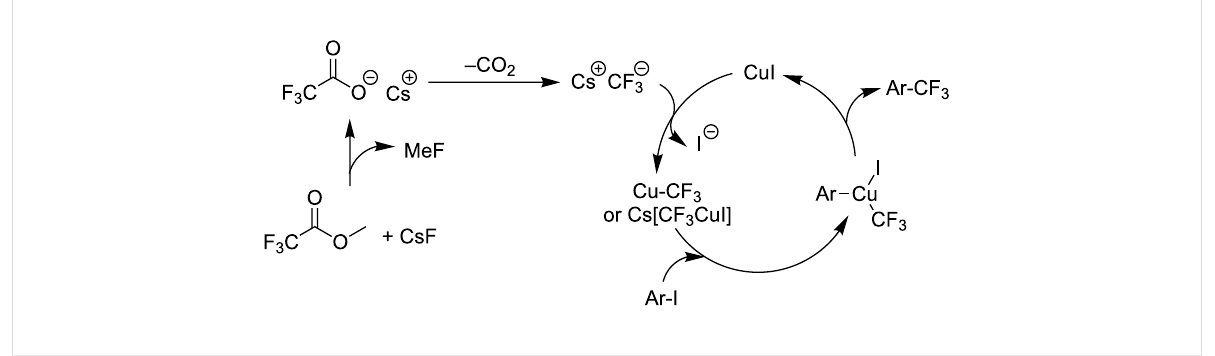
Figure 5: Postulated reaction mechanism for Cu-catalyzed trifluoromethylation reaction using MTFA as trifluoromethylating agent [81].